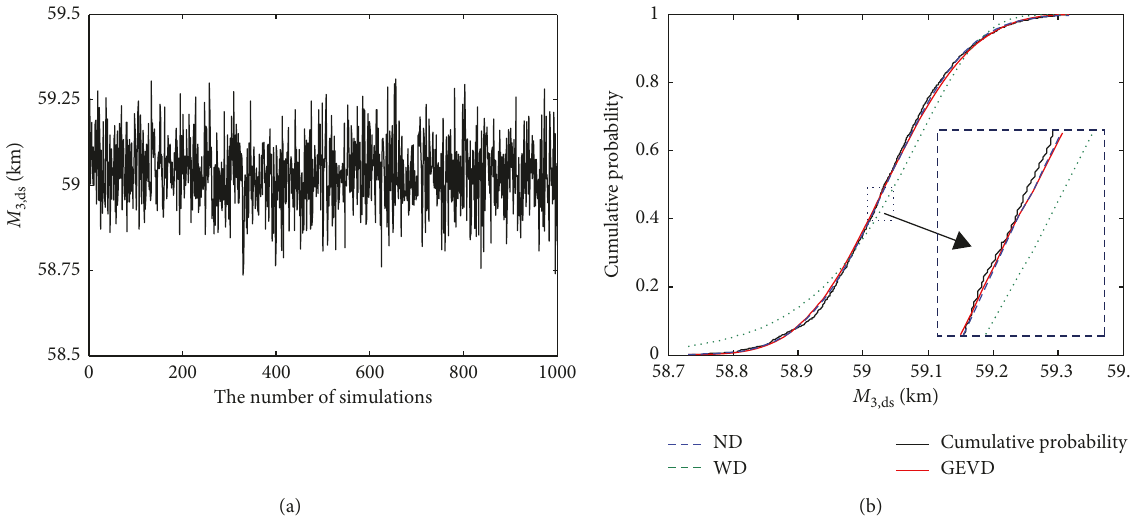
Figure 13: The 1000 values of M